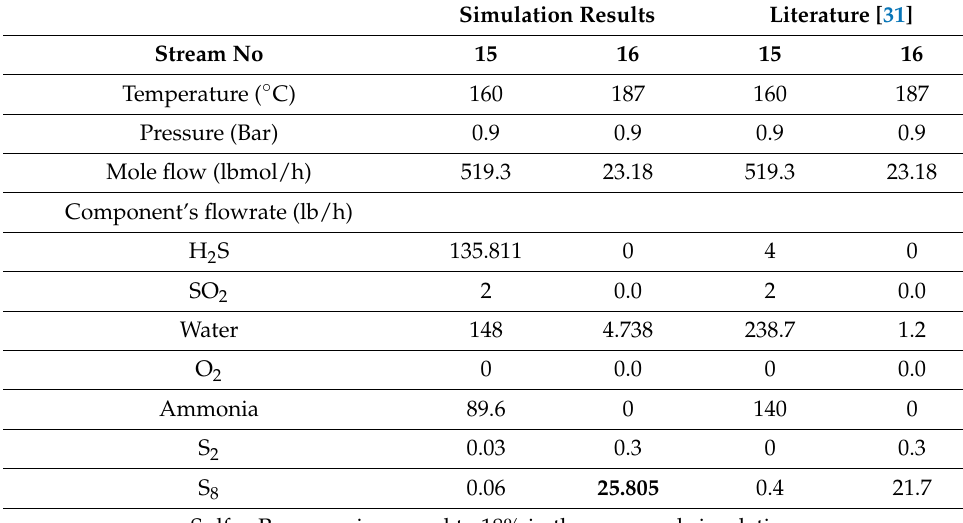
Table 15. Production results compared with the